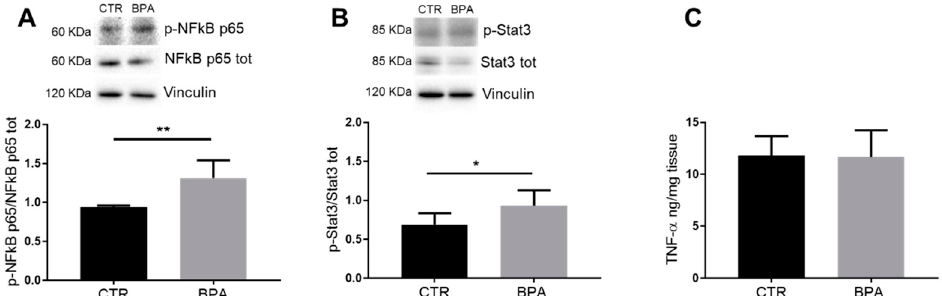
Figure 7. Effects of prenatal exposition to 2.5 µg/kg/day of BPA on inflammatory parameters in fetal livers of female rats. The figure shows typical Western blot of p-NFkB p65 ( A ) and p-Stat3 ( B ) and their total levels in fetal livers from female CTR animals and the ones prenatally exposed to BPA. The graphs represent the activation state of the proteins in fetal liver lysates. ( C ) Total level of TNF- α in liver lysates of female fetuses measured by ELISA assay kit. Values are expressed as mean ± SD, n = 6 for each experimental group. Differences between groups were considered as significant at p < 0.05 and were analyzed with unpaired Student’s t test. * p < 0.5; ** p < 0.01 vs. CTR.